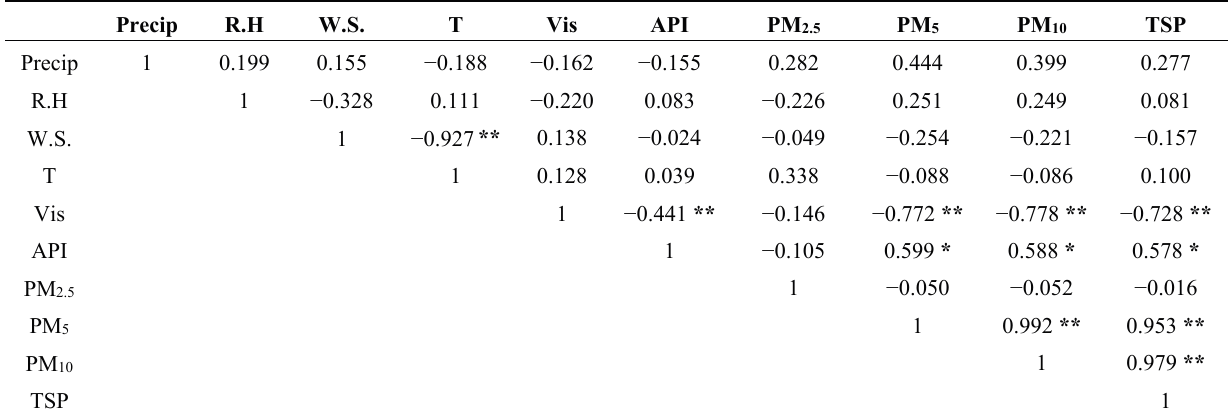
Table 3. Relationships between PM, air quality and meteorological parameters during the sampling